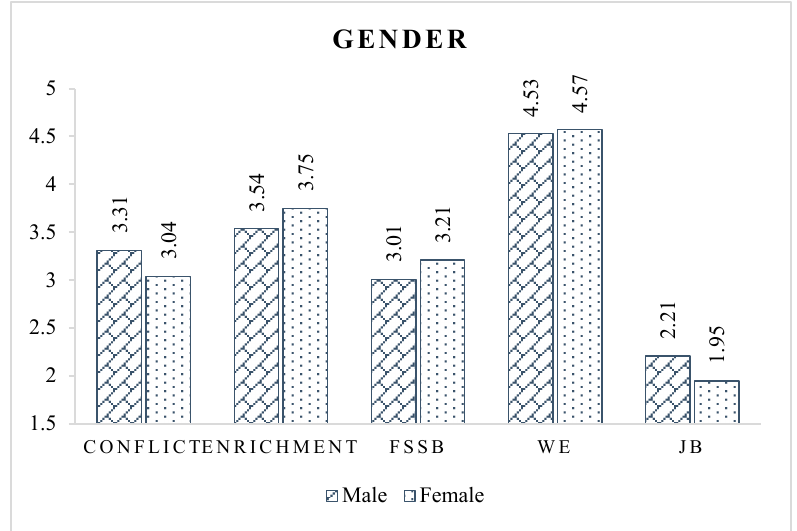
Figure 3. Latent variable scores of different gender groups.